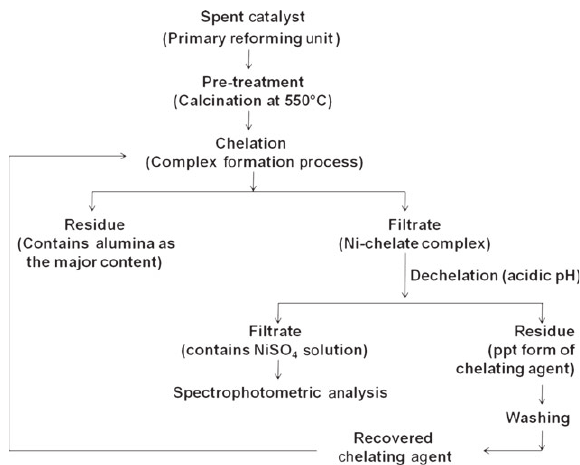
Figure 2 Process flow chart of chelant assisted Ni extraction